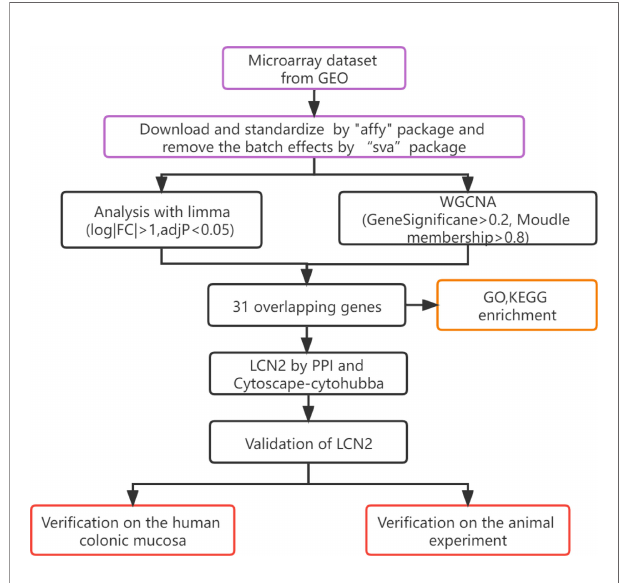
FIGURE 1 | Flow diagram of the analysis